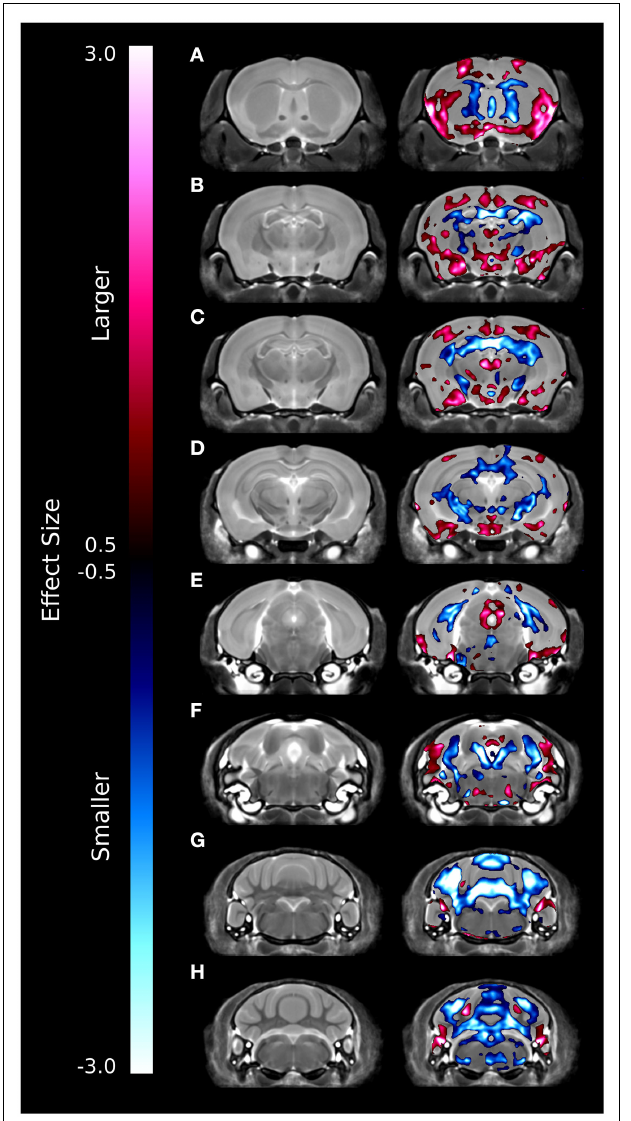
FIGURE 2 | Coronal slices highlighting the differences between the ITG β 3 mouse and theWT. The slices are arranged from anterior (A) to posterior (H) .These maps were created by thresholding the effect size measurement by theTFCE multiple comparison correction; therefore only effects sizes of significance (TFCE corrected p value < 0.05) are displayed. Anything displayed in blue indicates a smaller volume in the ITG β 3 mouse and anything displayed in red indicates a larger volume in the ITG β 3 mouse.